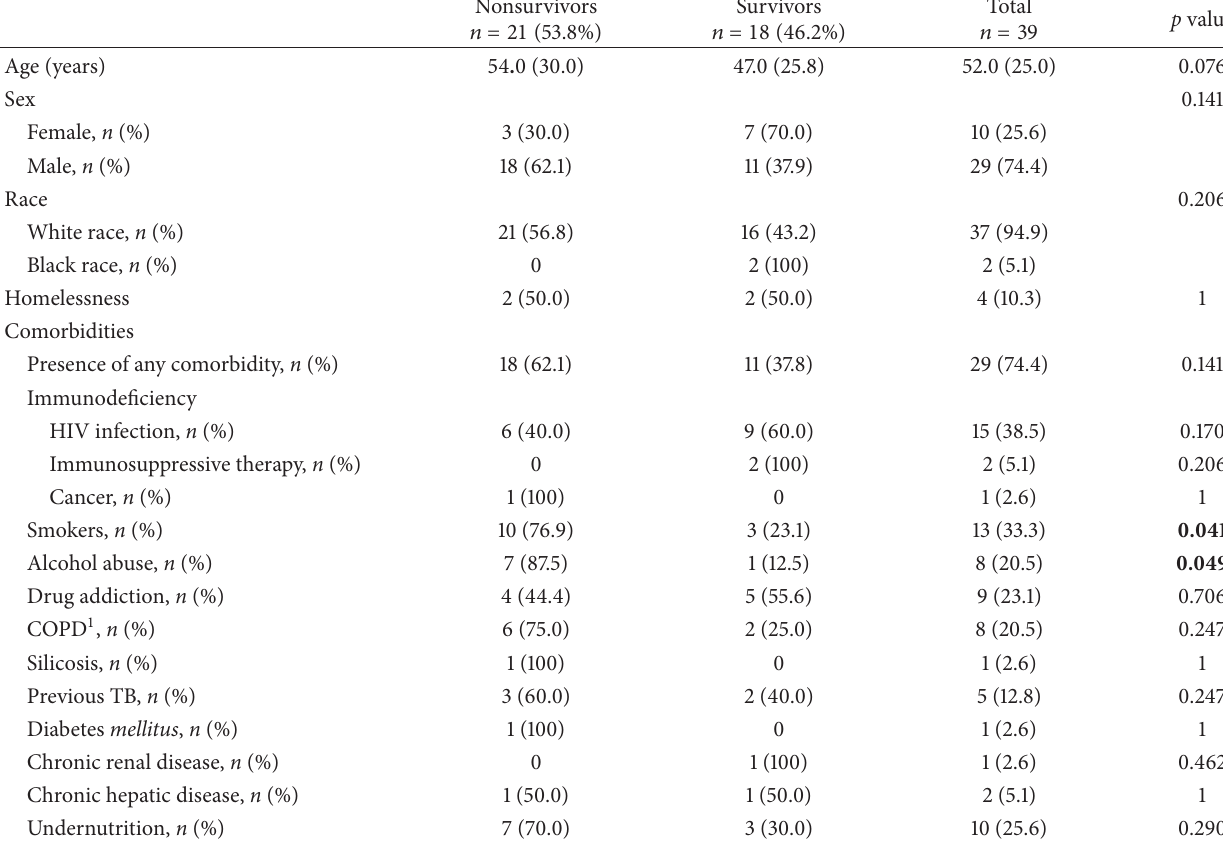
Table 1: Patient characteristics, including comparison between survivors and